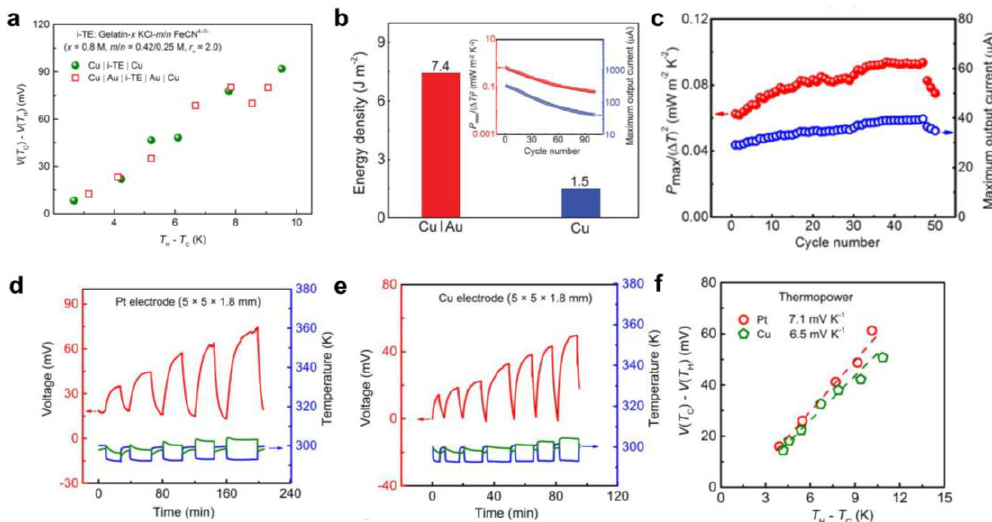
Figure 4. Effect of electrode on the thermopower. ( a ) Thermopower measurement for the as-fabricated i-TE cells Cu | i-TE | Cu and Cu | Au | i-TE | Au | Cu (15 × 15 × 1.8 mm), where i-TE represented Gelatin-0.8 M KCl-0.42/0.25 M FeCN 4 − /3 − (rv = 2.0). Au (40 nm) was coated on the Cu foil with smooth surface by ion sputtering. ( b ) The corresponding total energy density of the initial 50 cycles for i-TE cell with rough Cu | Au (40 nm) and smooth Cu as electrodes. Normalized output power Pmax/(DT)2 and maximum output current of 100 cycles in an i-TE cell (Cu | Au | i-TE | Au | Cu, 15 × 15 × 1.8 mm) are shown in the inset. ( c ) Corresponding Pmax/(∆T)2 and maximum output current varying with the cycle number. Thermopower measurement of i-TE material of Gelatin-0.8 M KCl with ( d ) Pt electrode (Pt | i-TE | Pt, 5 × 5 × 1.8 mm) and ( e ) Cu foil electrode (Cu | i-TE | Cu, 5 × 5 × 1.8 mm). ( f ) Thermopower measurement of the i-TE material (Gelatin-0.8 M KCl) with different electrodes, showing the 7.1 and 6.5 mV K −1 for the Pt electrode and Cu electrode, respectively. This suggests that the thermopower is relatively independent of the choice of electrode. The V(T C )-V(T H ) is the voltage difference, while the T H -T C is the temperature difference. (Reproduced with permission from [85]. Copyright 2020, AAAS.).